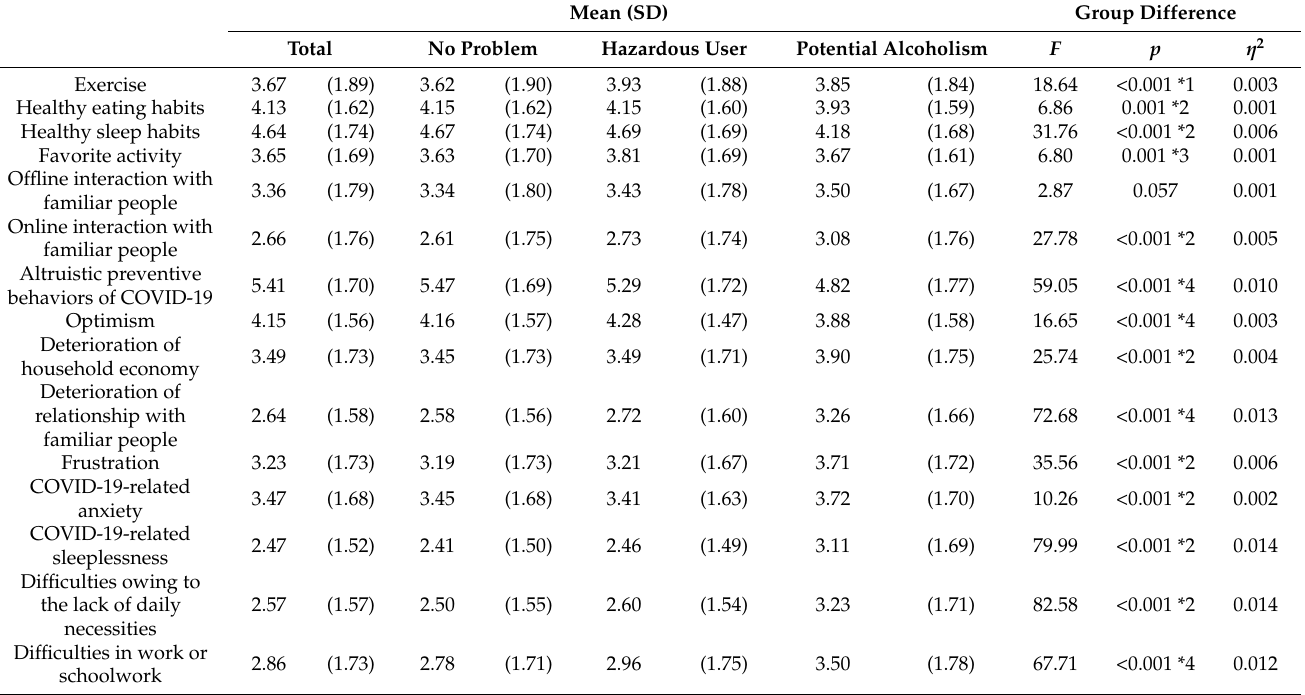
Table 5. Comparisons of COVID-19 related variables between three AUDIT